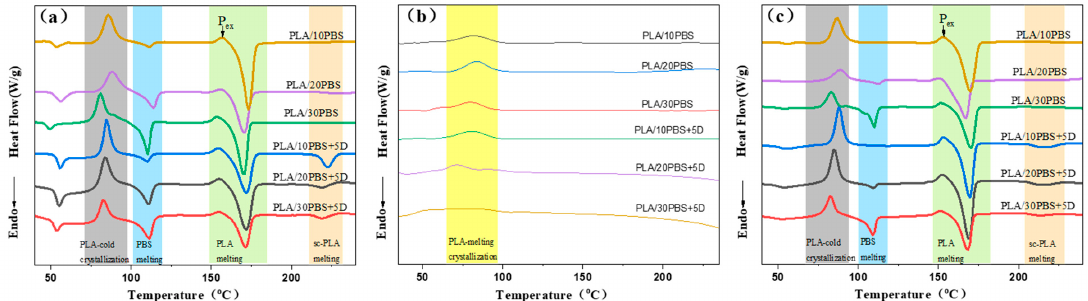
Table 2. Differential scanning calorimetry (DSC) parameters for crystallization of poly ( L -lactide) (PLLA)/PBS and PLLA/PBS/PDLA in the first heating process. PLA / PBS